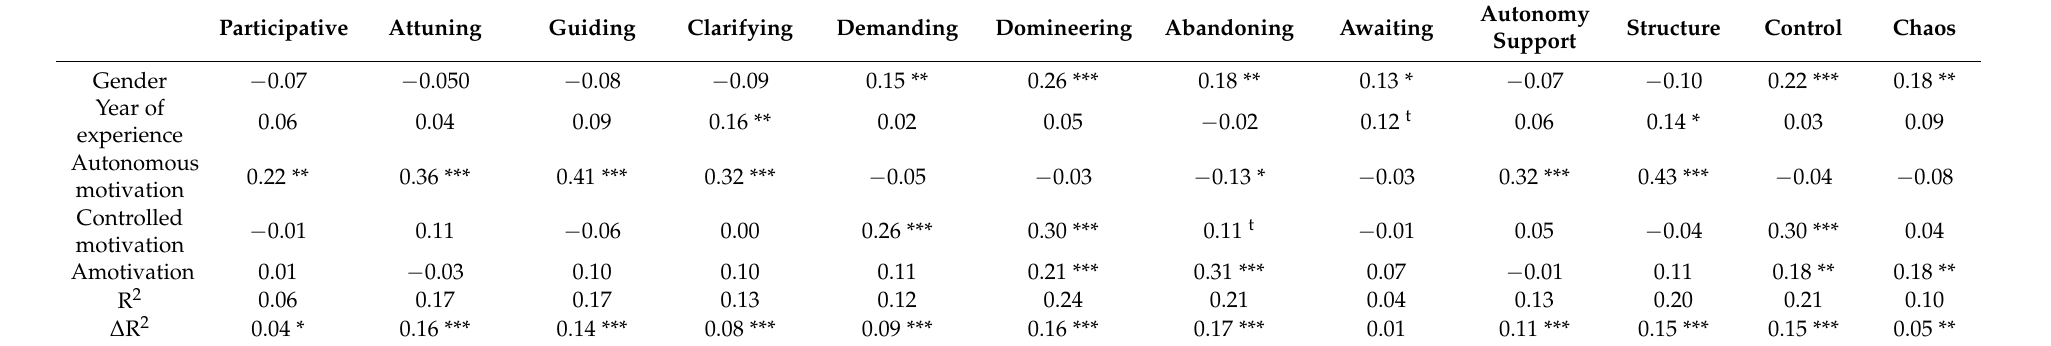
Table 6. Concurrent analysis with teachers’ motivation variables (N =